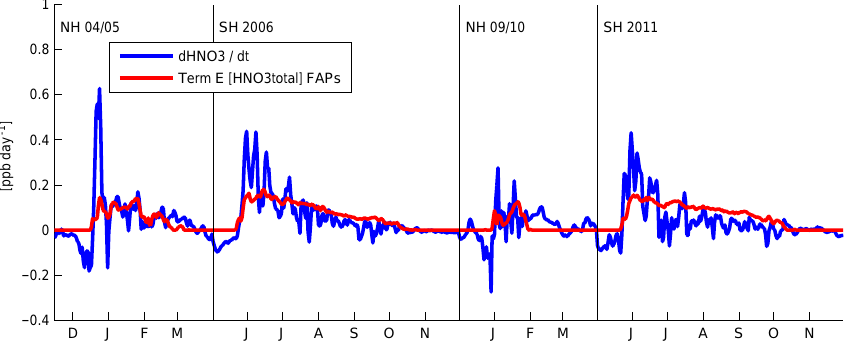
Figure 13. Fit of term E for the Arctic winter 2004/2005, the Antarctic winter 2006, the Arctic winter 2009/2010 and the Antarctic win- ter 2011 at 54hPa. Vortex-averaged rate of change of HNO 3 by denitrification modeled by ATLAS plus the rate of change of HNO 3 by chemical reactions modeled by ATLAS (blue) and the fitted term E (red). Tick marks on the horizontal axis show start of